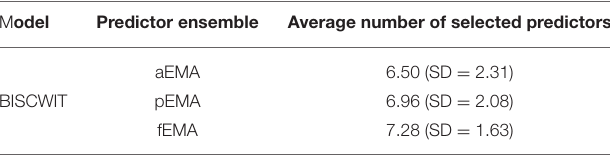
TABLE 2 | The average number of selected predictors for BISCWIT models across 46 participants. M